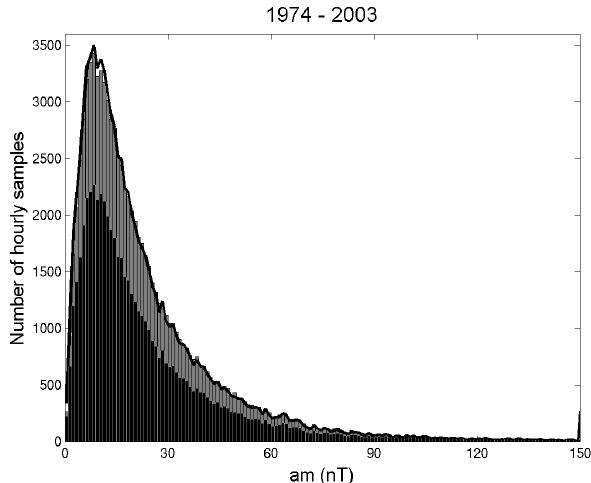
Figure 3. Fig. 3. Distributions of hourly values of the geomagnetic am (grey histogram) and am w (black histogram) indices for 1974–2003. The final bin is for all samples with am or am w > 150nT. The solid black line is the distribution of the am w values scaled by the overall ratio between all am and am w sample numbers.